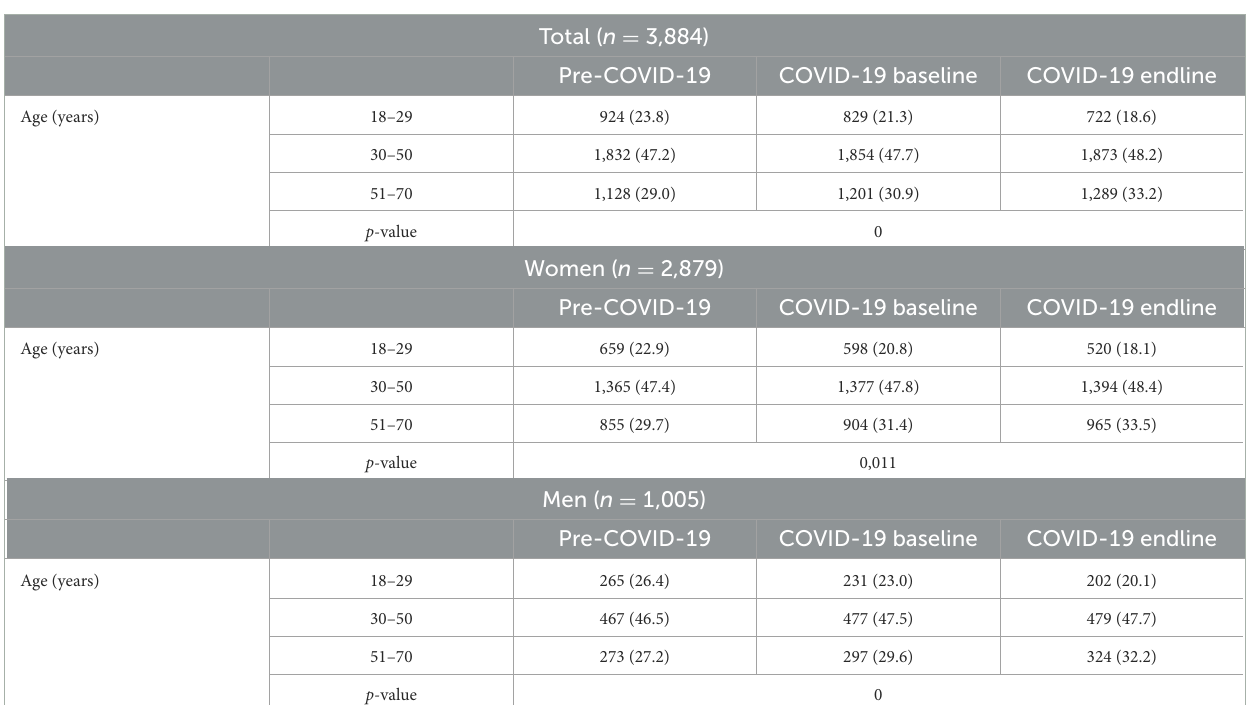
TABLE 1 Healthcare workers sociodemographic ( n , %) by time period ∗ and